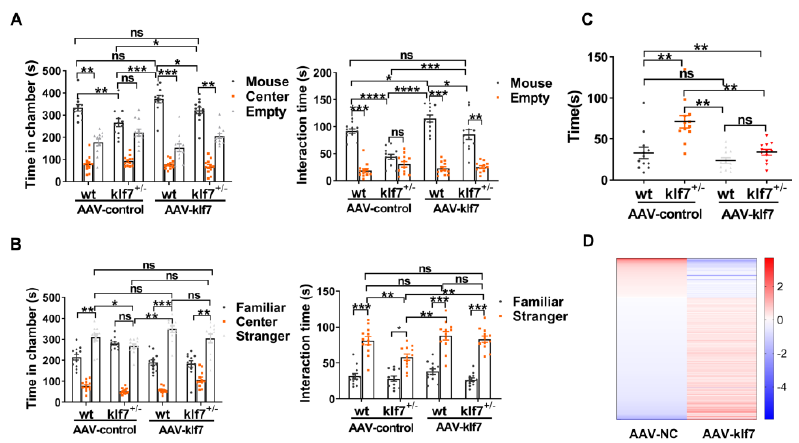
Figure 4. Increasing klf7 levels rescue the core symptoms of ASD in klf7 +/ − mice. ( A , B ) Histogram showing the amount of time spent in the chamber containing either the stranger mouse or the novel mouse and the amount of time spent interacting with the stranger mouse or novel mouse by AAV-control-injected WT mice, AAV-control-injected klf7 +/ − mice, AAV-klf7-injected WT mice and AAV- klf7-injected klf7 +/ − mice in the three-chambers sociability test. Whereas klf7 +/ − mice in the AAV-control group did not show an obvious social preference, klf7 +/ − mice in the AAV-klf7 group showed improved social ability. Notably, elevating klf7 levels rescued the abnormal social ability of klf7 +/ − mice. ( C ) Histogram showing the amount of time the AAV control-injected WT mice, AAV control-injected klf7 +/ − mice, AAV- klf7-injected WT mice and AAV-klf7-injected klf7 +/ − mice spent grooming in the 10 min self-grooming test. Klf7 +/ − mice in the AAV-control group displayed an increased grooming time, indicating repetitive behavior. The abnormal grooming behavior was alleviated in the AAV-klf7 group. ( D ) Summary graph showing autism-related genes dysregulated after klf7 deletion whose expression was restored by elevating klf7 levels in klf7 +/ − mice. The data are the mean ± SEM. n = 12 per group in A-C. * p < 0.05, ** p < 0.01, *** p < 0.001, **** p < 0.0001,